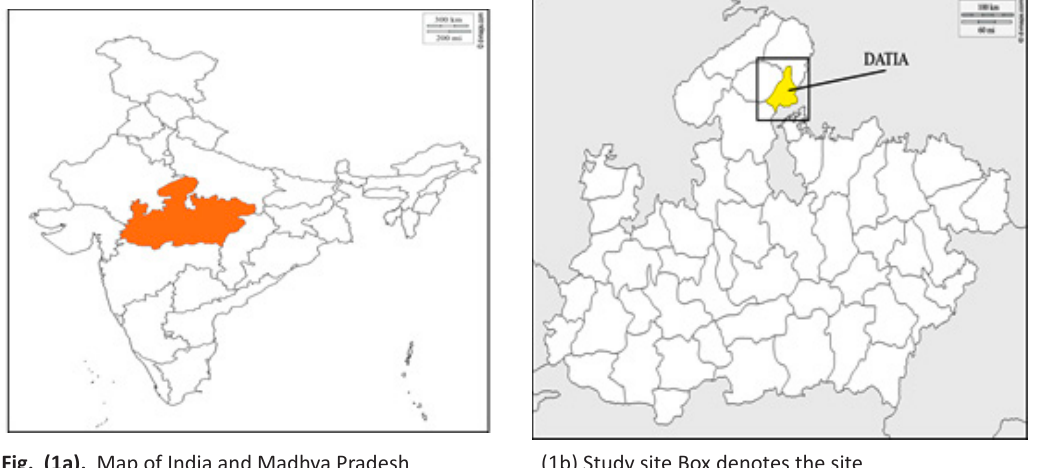
Fig. (1a). Map of India and Madhya